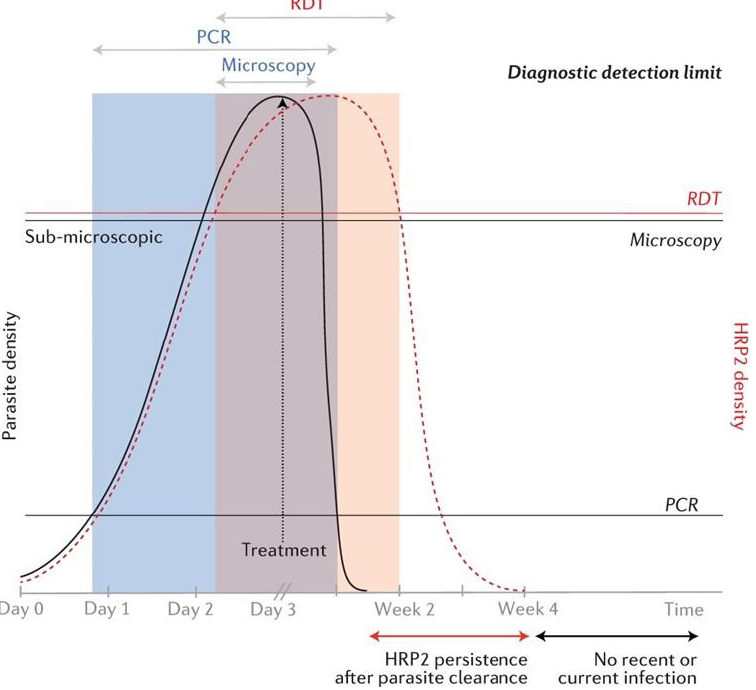
Figure 4. Schematic chart of diagnostic detection limits of microscopy, HRP2-based RDT, and PCR with respect to parasite and HRP2 density. The black line curve represents parasite density and the red dotted curve represents HRP2 gene density. Time scale is in days pre-treatment and in weeks post-treatment. Horizontal lines over the chart represent the detection limits of the three methods respective to parasite and HRP2 densities. The shaded areas represent detectability of parasites by the three methods over time. Reprinted from Wu, L., van den Hoogen, L.L., Slater, H., Walker, P.G.,